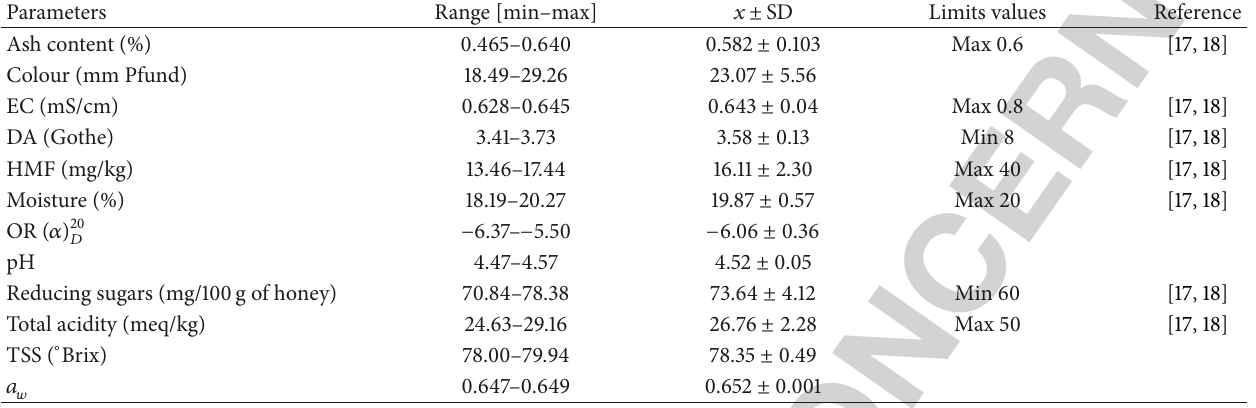
Table 1: Results of the physicochemical parameters of strawberry tree ( Arbutus unedo ) honey